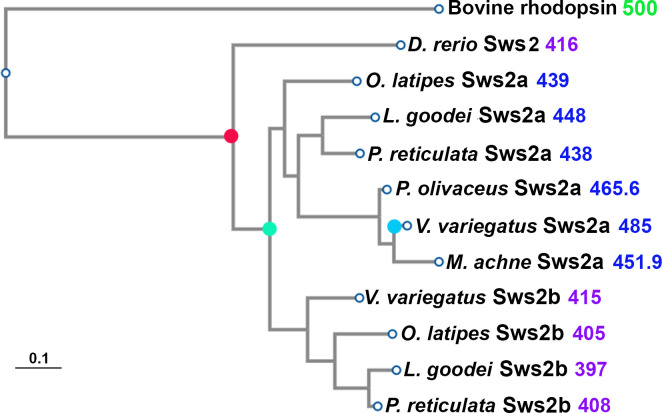
Evolutionary relationships of teleost Sws2 opsin proteins used in the simulations, as inferred by PhyML.Red filled circle indicates the speciation event that occurred prior to the duplication (green filled circle) of the sws2 opsin genes in teleosts [18]. The duplication generated the sws2a clade, which encode photopigments with λmax values that are shifted to longer wavelengths, and the sws2b clade, which encode photopigments with short-wavelength-shifted λmax values. The blue filled circle indicates the amino acid substitution A269T (with numbering standardized to the bovine rod opsin sequence) that is likely to be the spectral tuning site important for a further shift of the λmax value of V. variegatus Sws2a to longer wavelengths [23]. Experimentally measured λmax values (in nm) are indicated next to the name of each opsin and are color-coded for λmax values that are <430 nm (violet) or >430 nm (blue).